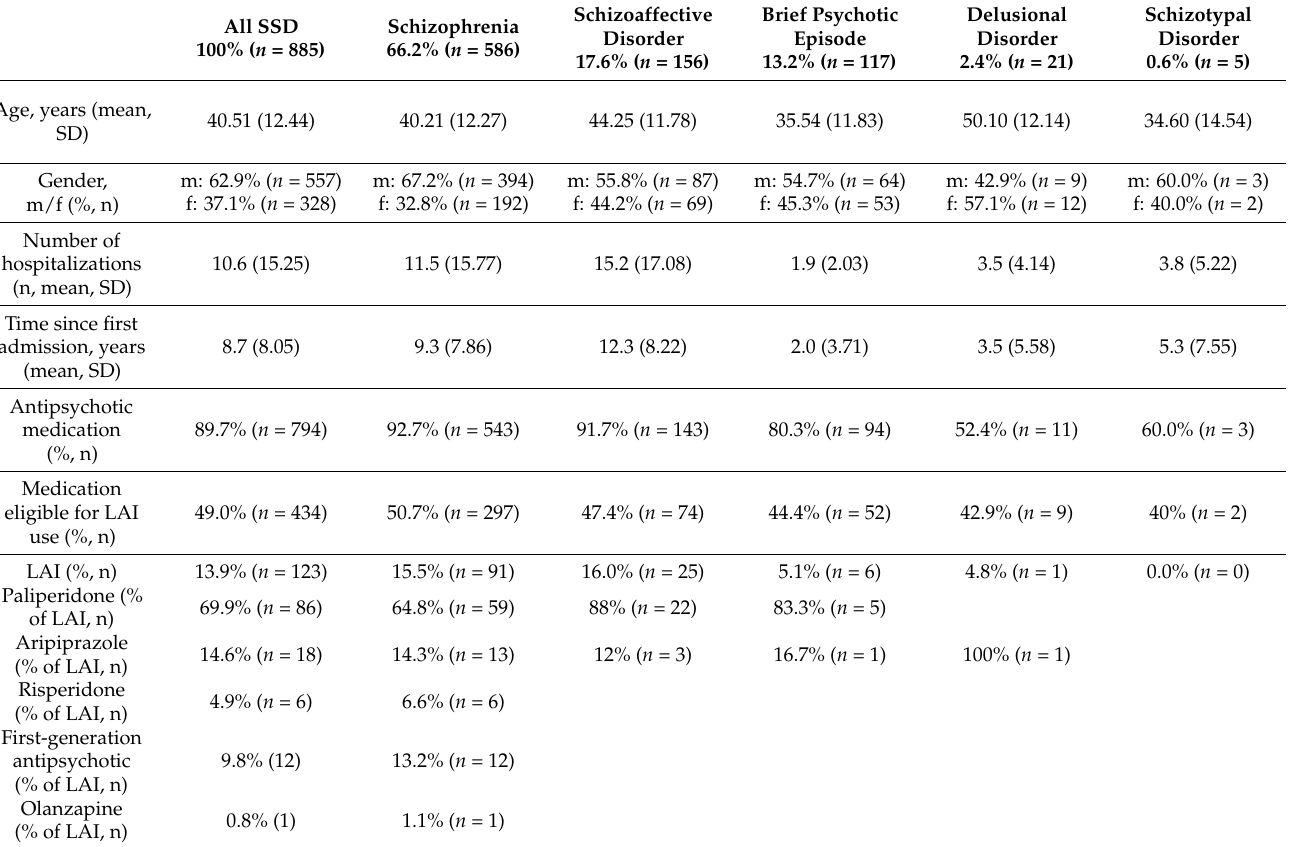
Table 1. Demographic and clinical